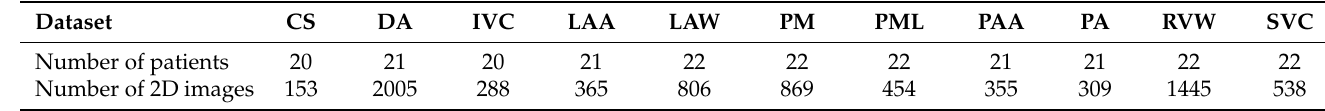
Table 1. Dataset details. Number of different patients per cardiovascular structure and total number of 2D